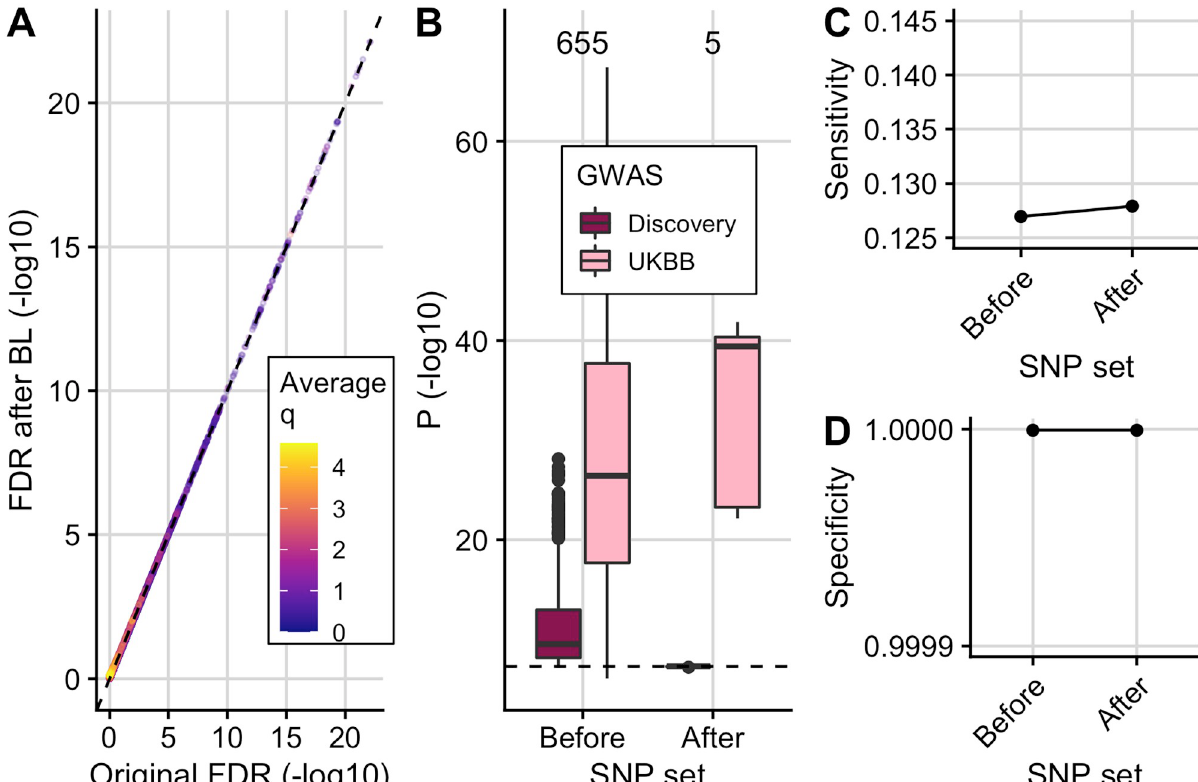
Fig 5. Using Boca and Leek’s FDR regression to leverage H3K27ac data with asthma GWAS p -values. (A) (-log 10 ) adjusted p -values from BL against raw (-log 10 ) FDR values coloured by average value of q (H3K27ac fold change value). (B) Box plots of (-log 10 ) p -values in the discovery GWAS data set and the UK Biobank data set for the 655 SNPs that were FDR significant in the original GWAS (“before”) and 5 newly significant SNPs after applying BL (“after”). Black dashed line at genome-wide significance threshold (5 × 10 − 8 ). (C) Sensitivity and (D) specificity proxies for the results. Sensitivity proxy is calculated as the proportion of SNPs that are FDR significant in the UK Biobank data set that are also FDR significant in the original GWAS or after applying BL. Specificity is calculated as the proportion of SNPs that are not FDR significant in the UK Biobank data set that are also not FDR significant in the original GWAS or after BL.